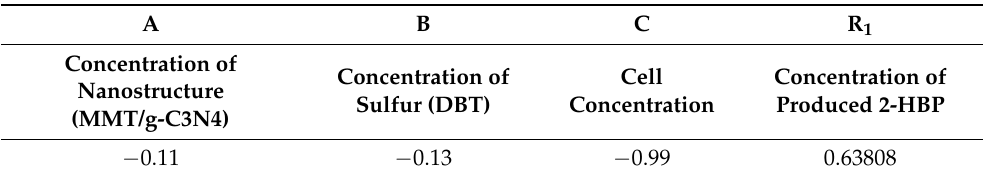
Table 6. Optimum conditions for R 1 response for Rhodococcus erythropolis IGTS8 in the presence of the